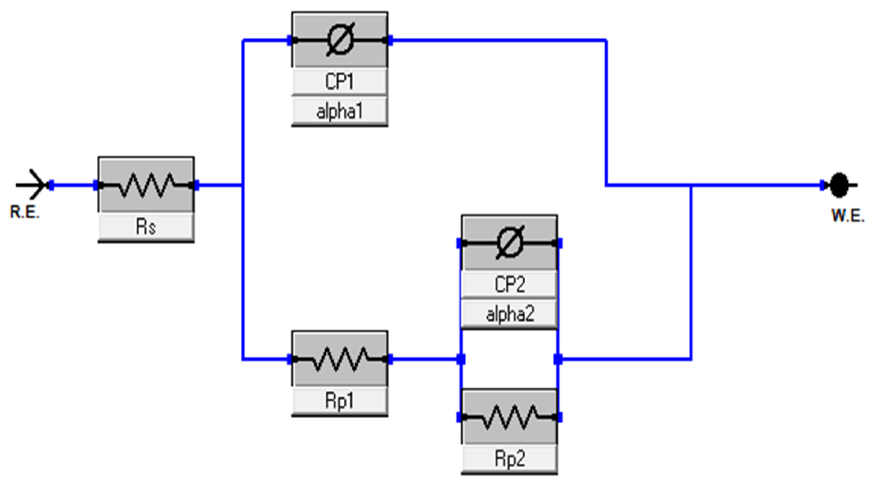
Figure 7. Equivalent circuit to model the behavior of the Bi 3.75 La 0 . 25 Ti 3 O 12 and Bi 3 La 1 Ti 3 O 12 coatings.